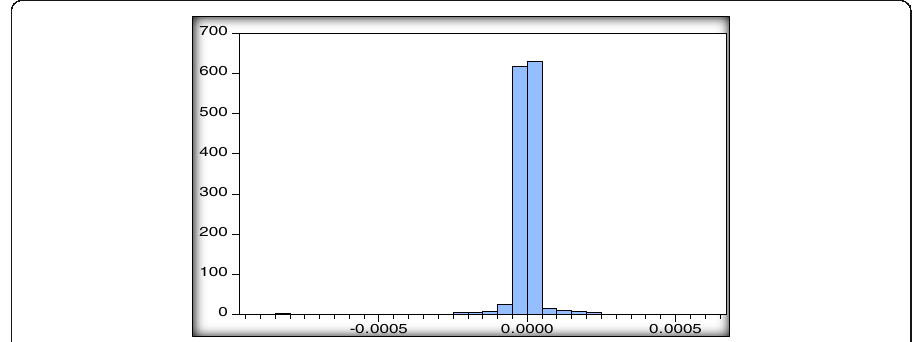
Fig. 3 Histogram representing the difference in log price of KOTAK GETF. In the histogram, the horizontal axis represents the difference in log price and the vertical axis represents the number of times each value occurs, i.e.: it is the probability density function of the difference in log price of KOTAK